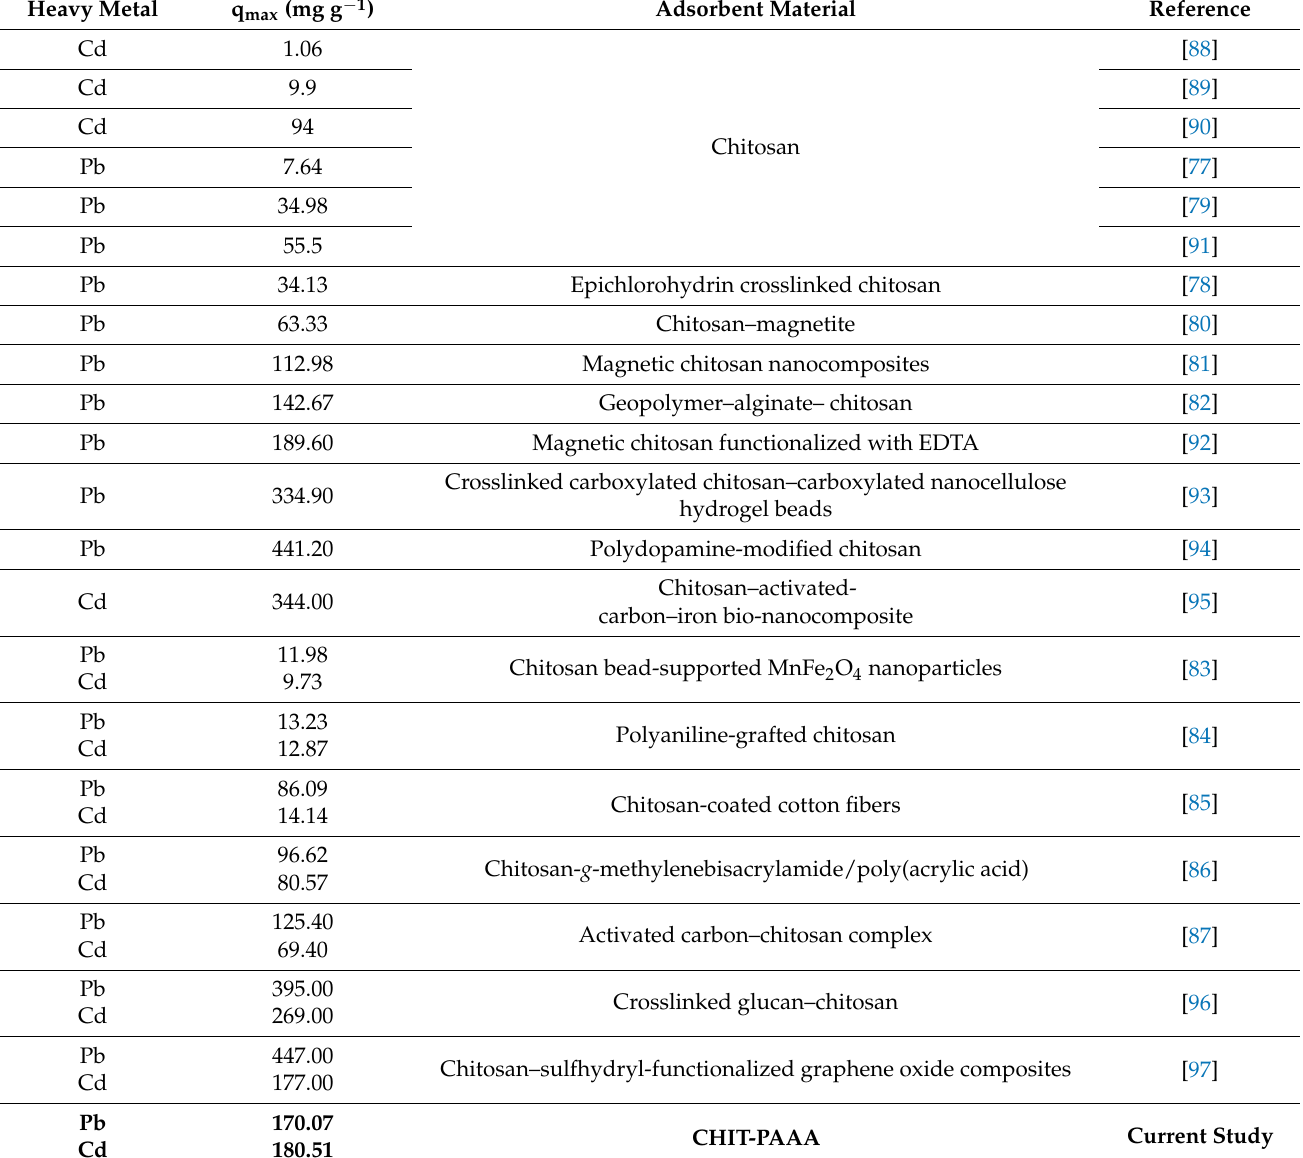
Table 1. Comparison of Pb and Cd adsorption capacities reported in the literature for different adsorbent